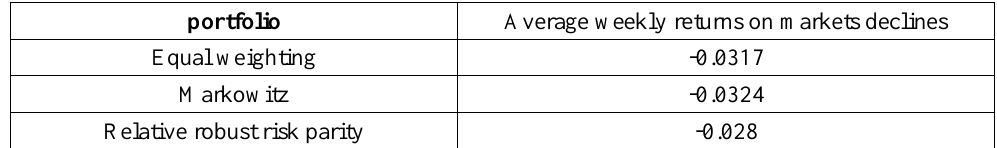
Table 10. Performance of portfolios in market